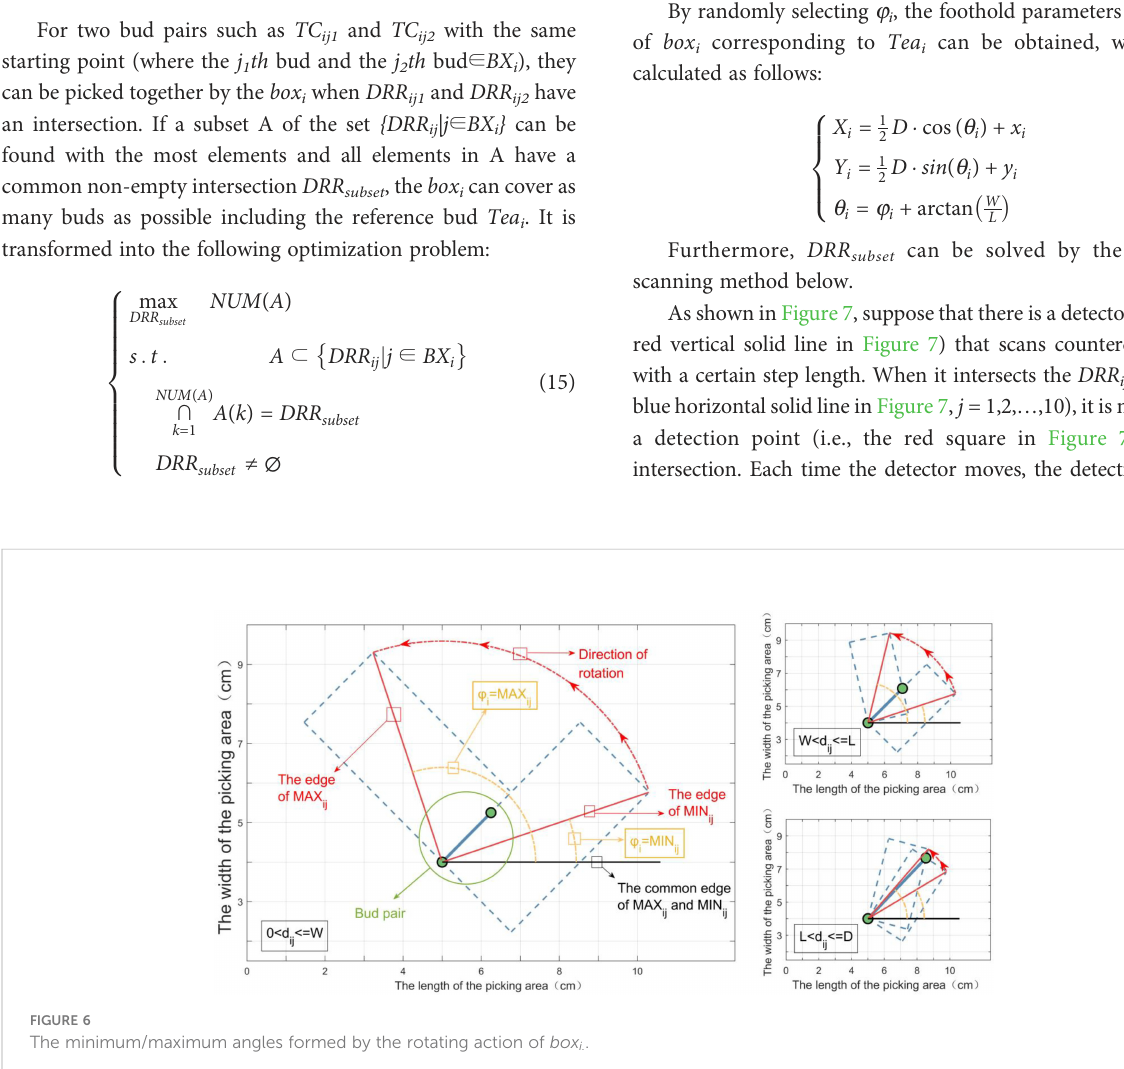
FIGURE 5 The bud